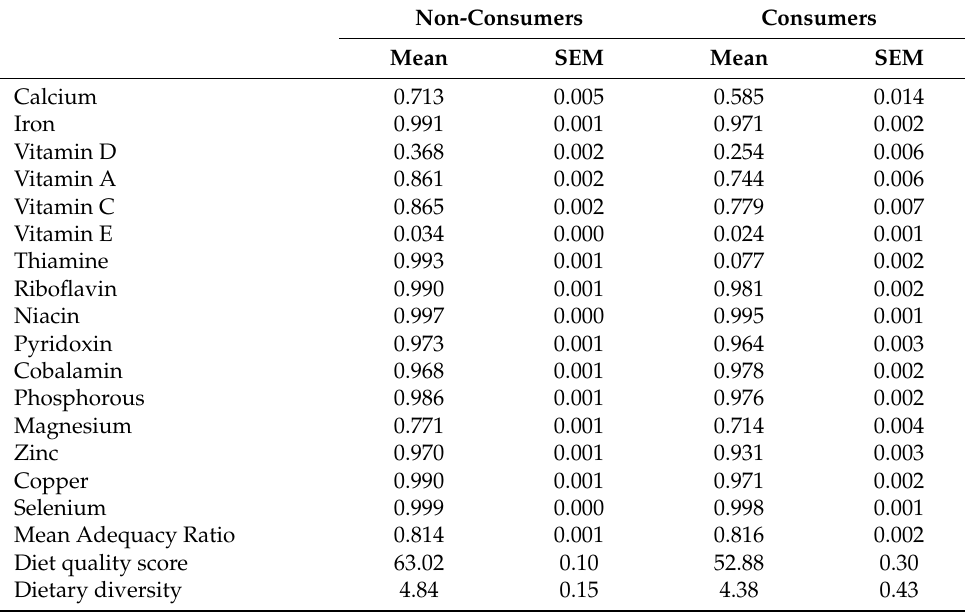
Table 5. Nutrients Adequacy Ratio according to alcohol consumption. Non-Consumers Consumers Mean SEM Mean